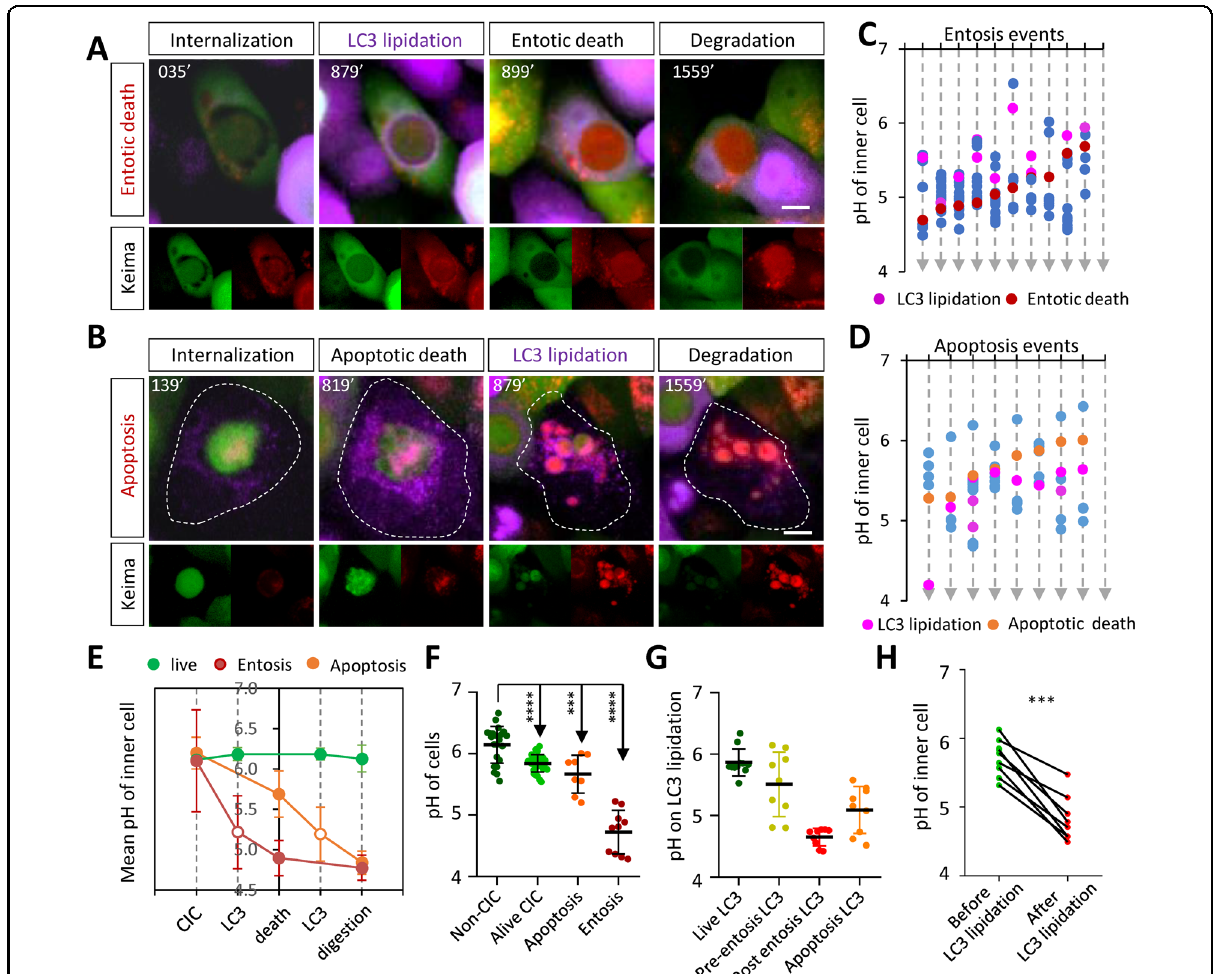
Fig. 4 The analysis of vacuolar acidi fi cation along with LC3 lipidation. Time-lapse images for keima (excitation at 440 nm in green, 550 nm in red) and GFP-LC3 (purple) during the entotic ( A ), or apoptotic ( B ) death of internalized MCF10A cell. Scale bars, 10 μ m. Time course-based plotting of vacuolar pH in related to LC3 lipidation during the entotic ( C ), or apoptotic ( D ) death of internalized cells. E The average pH dynamics for inner cells that were alive (green), or underwent apoptotic death (orange), or underwent entotic death (red), respectively. F The pH for normal cells (non-CICs), alive inner cells, apoptotically dead inner cells and entotically dead inner cells, respectively. G The vacuolar pH on the moment of LC3 lipidation, including LC3 lipidation for alive inner cells (green), LC3 lipidation before entosis (yellow), LC3 lipidation after entosis (red) and LC3 lipidation after apoptosis (orange). H Changes in vacuolar pH before and after LC3 lipidation. ** p < 0.01; *** p < 0.001; **** p <